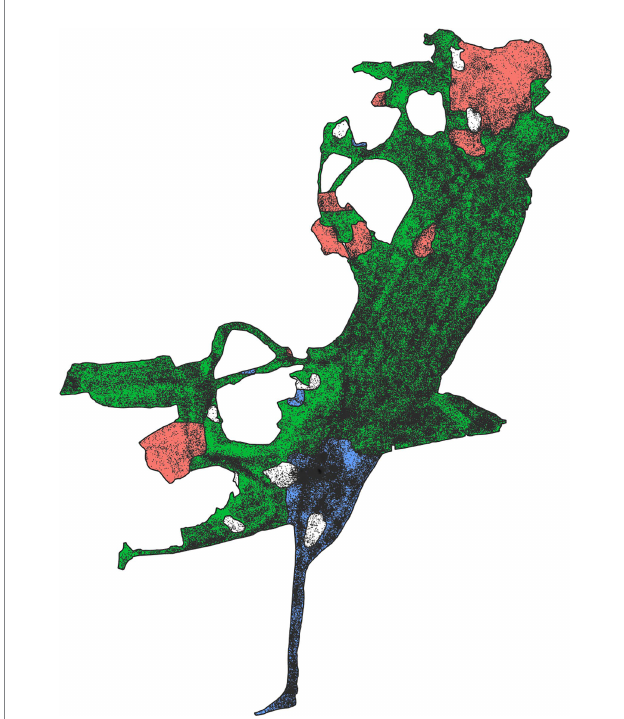
FIGURE 1 Heat map of horse feeding frequency from April–March from 2011 to 2021 (black points correspond to GPS positions). Cover of calcareous grassland types are marked red (xeric), green (dry) and blue (dry-mesic). White sites refer to dense patches of high woody vegetation and forests without remarkable grassland